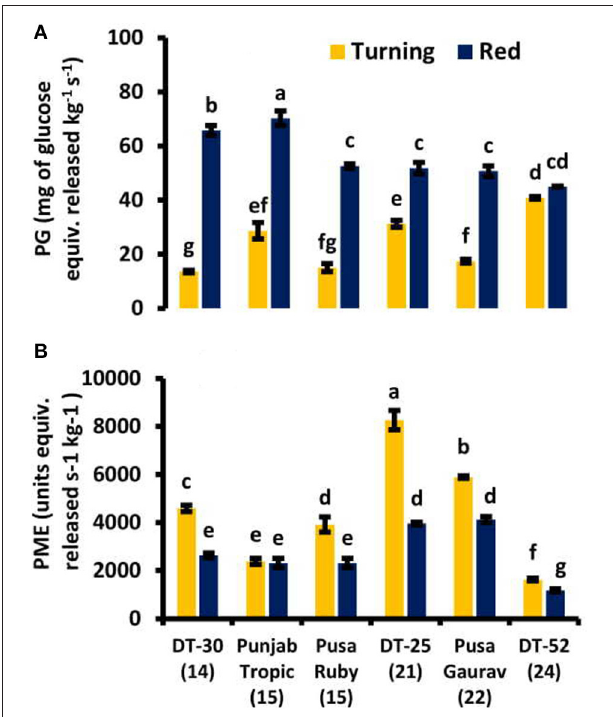
FIGURE 7 | Cell wall softening enzymes viz. (A) polygalacturonase (PG) and (B) pectin methyl esterase (PME) activities in tomato fruit at turning and red stages. Bottom axis represents the name of tomato lines, and numbers enclosed in parentheses represent shelf life. Each graph represents the mean of three replications, and vertical bars represent ±